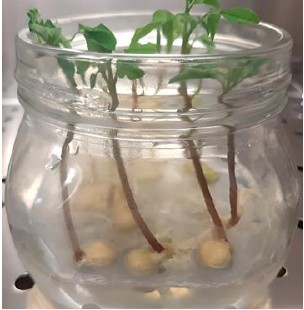
Figure 2. Germinative process of in vitro cultured Moringa seeds.